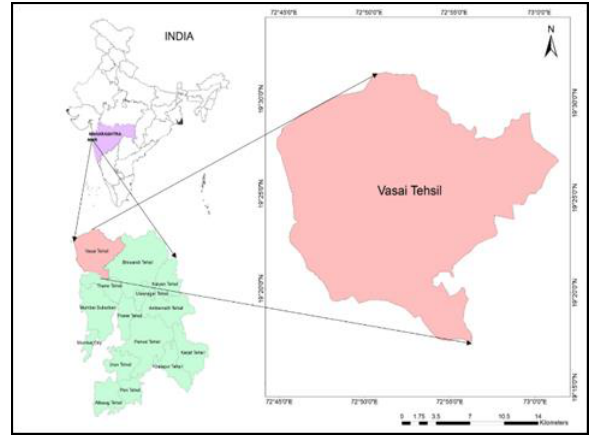
Figure 1. Study Area Vasai Tehsil